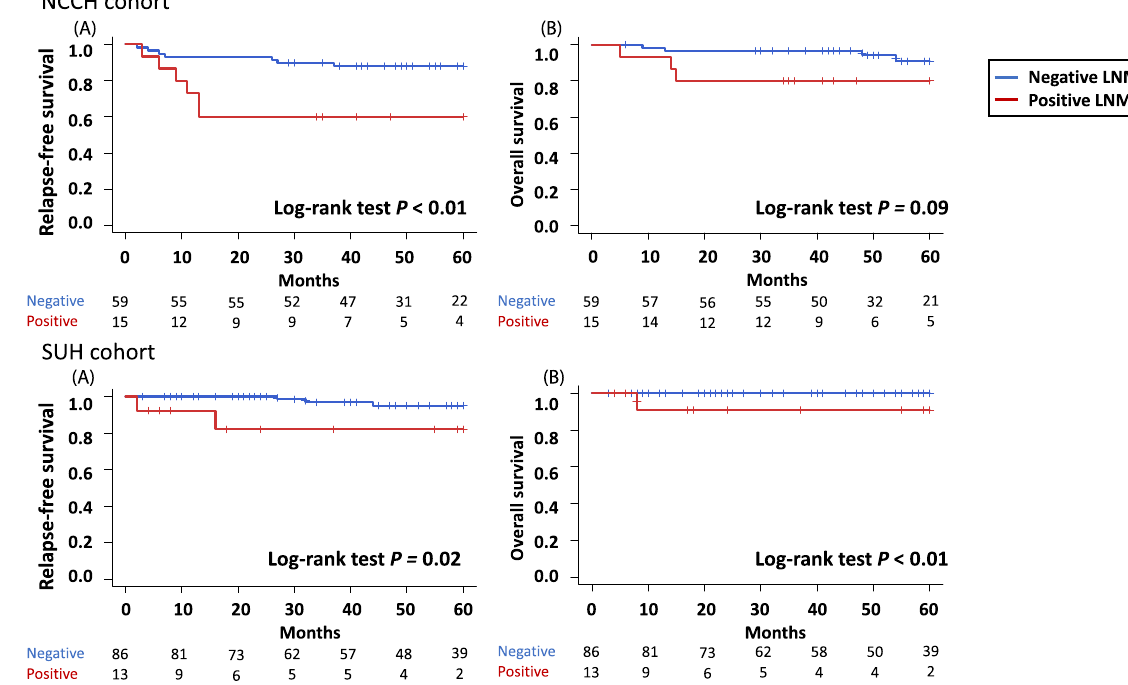
Figure 3. Kaplan–Meier survival curves according to the node-predicted status in patients without pathological lymph node metastasis. Top row, NCCH cohort 125 patients; bottom row, SUH cohort 129 patients. ( A ) RFS of positive lymph node metastasis prediction (red line) and negative lymph node metastasis prediction (blue line). ( B ) OS of positive lymph node metastasis prediction (red line) and negative lymph node metastasis prediction (blue line). LNM lymph node metastasis, NCCH National Cancer Center Hospital, OS Overall survival, RFS Relapse-free survival, SUH Showa University